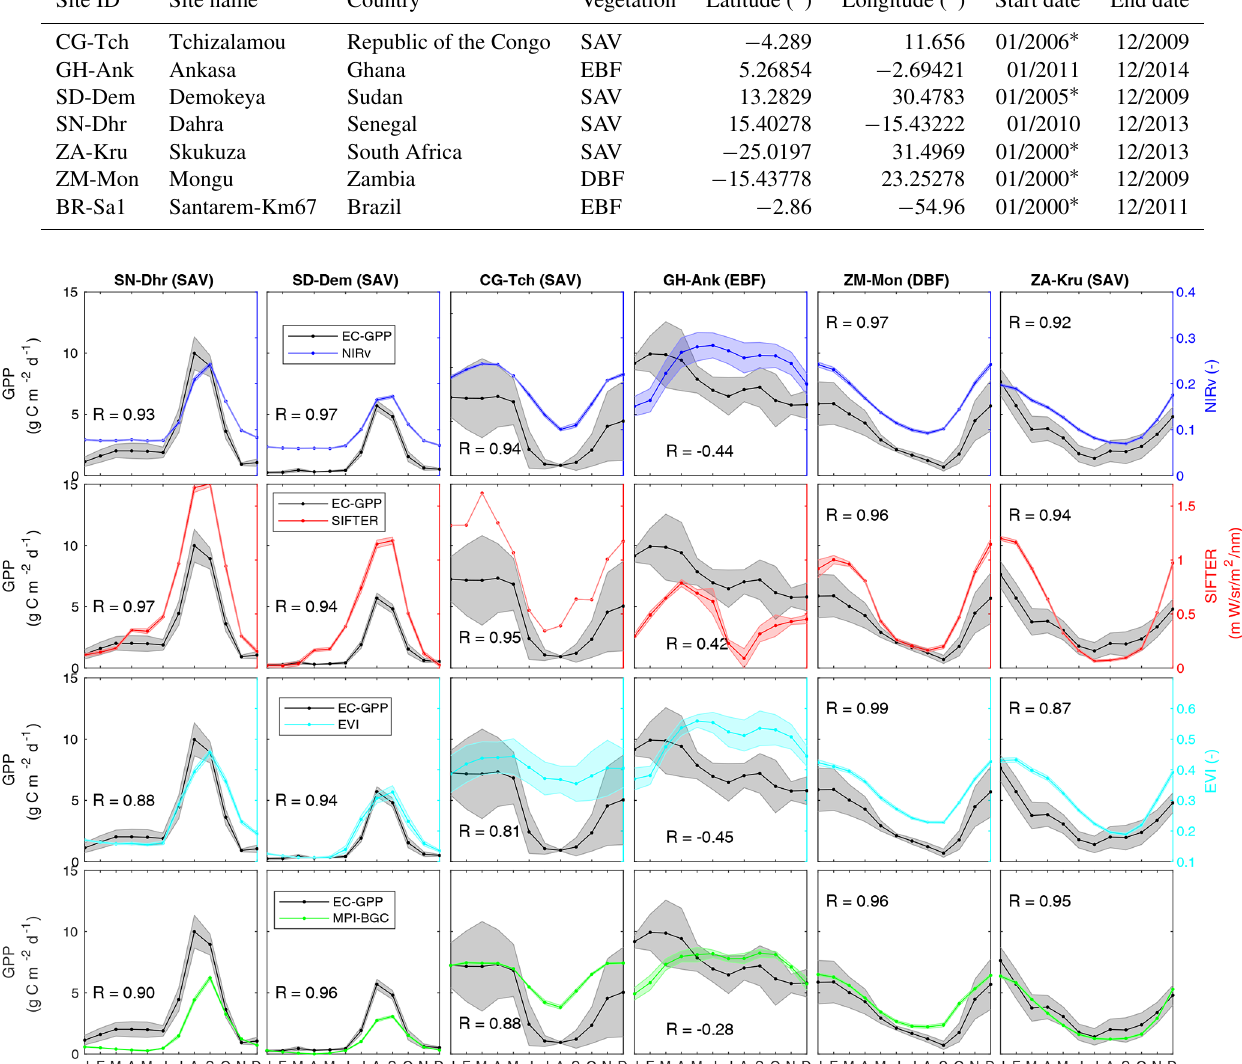
Figure 2. The skill of NIRv, SIF, the EVI, and MPI GPP in capturing the seasonal cycle of GPP from flux towers. The shaded area indicates the standard deviation around the monthly means. Note that NIRv, SIF, and the EVI do not have the same unit as GPP and their values are provided on the secondary y